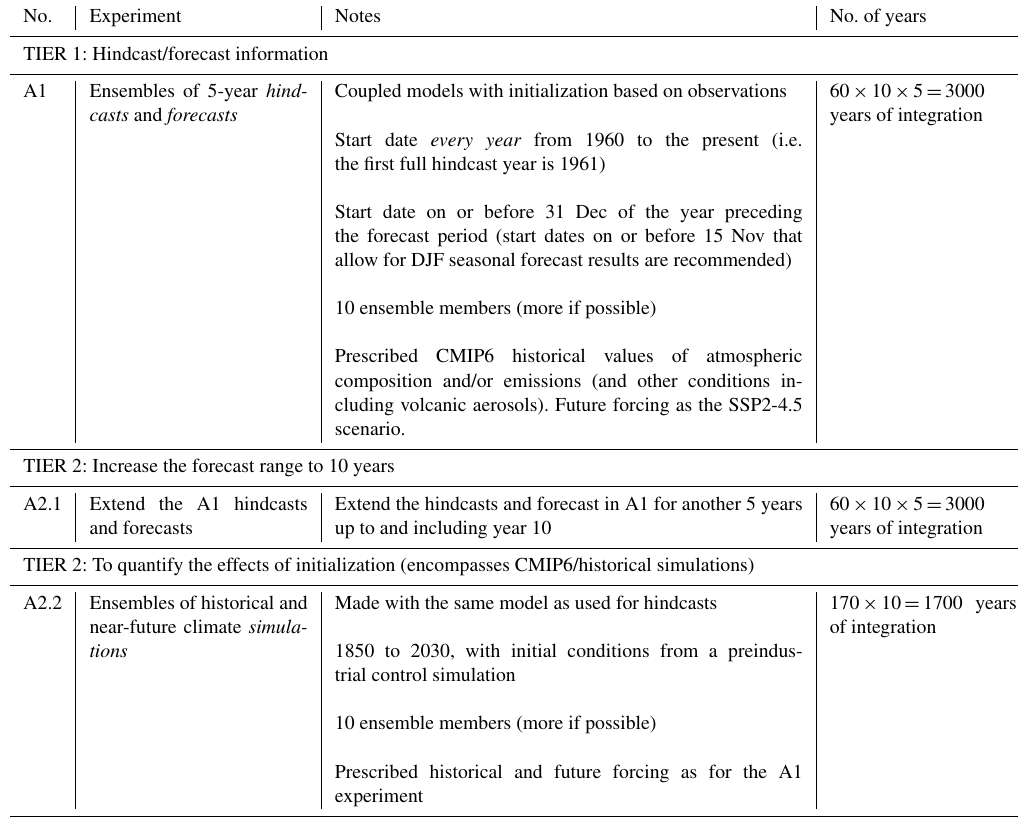
Table A1. Basic Component A: Hindcast/forecast experiments. No.